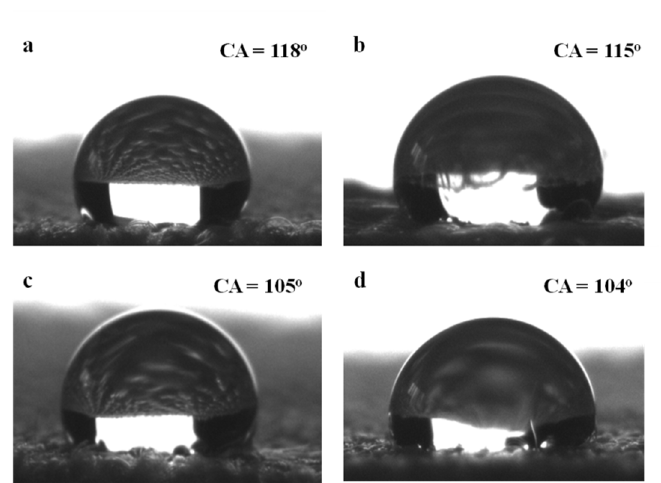
Figure 2. Images of water drops deposited on the PA surface modified with tethered polymers chains ( a ) PA- g -PS 66 -Br, ( b ) PA- g -PMMA 164 -Br, ( c ) PA- g -[(PS 66 -TEMPO)- mixed brushes -PDMAEMA 119 -Br], ( d ) PA- g -[(PMMA 164 -H)- mixed brushes -PDMAEMA 63 -Br].